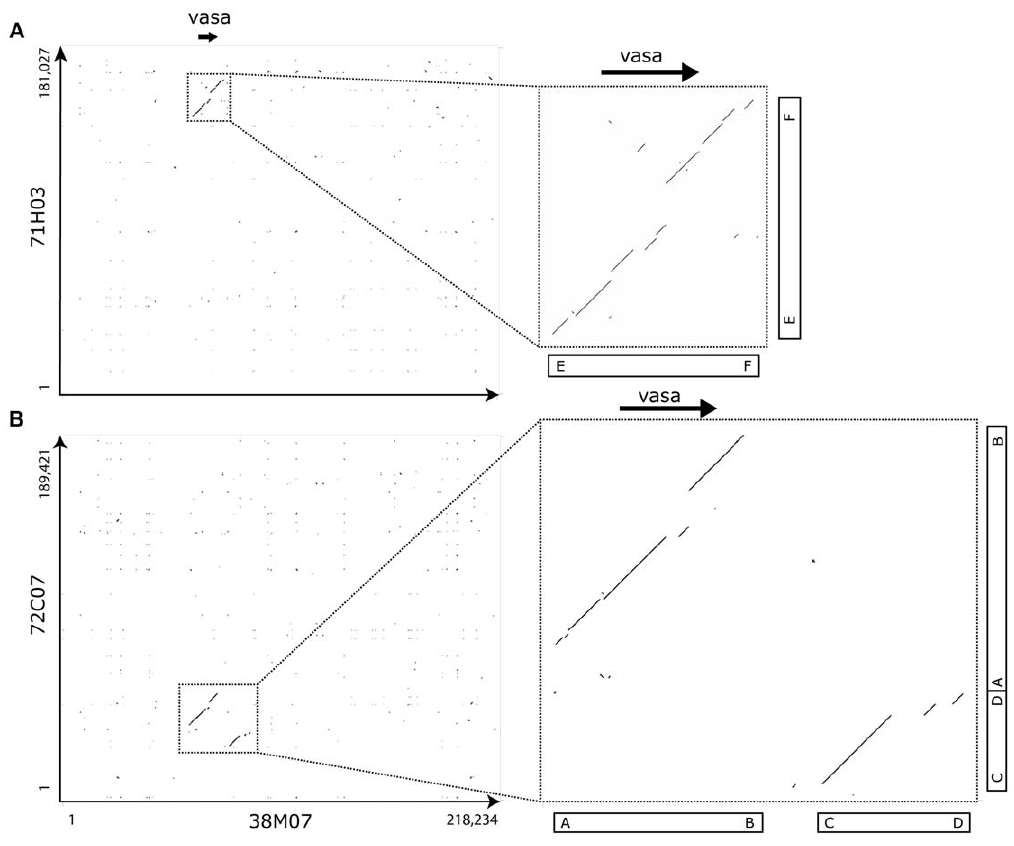
Figure 5. Only the vasa gene locus was duplicated in 71H03 and 72C07. (Left) Dotplots of 38M07 contigs against (A) 71H03 contigs and (B) 72C07 contigs. (Right) Magnification of the regions. Black arrow indicates the coding region of vasa gene. Boxes A–B and E–F show that only the vasa gene locus of 38M07 was duplicated into loci of 72C07 and 71H03, respectively. In addition, box C–D shows a difference in order in which the down stream region of the 38M07 vasa gene locus is duplicated into the upstream region of the 72C07 vasa gene locus. The boxes A–B, C–D and E–F correspond to those of Figures 7, 8, S3, S4 and S5.